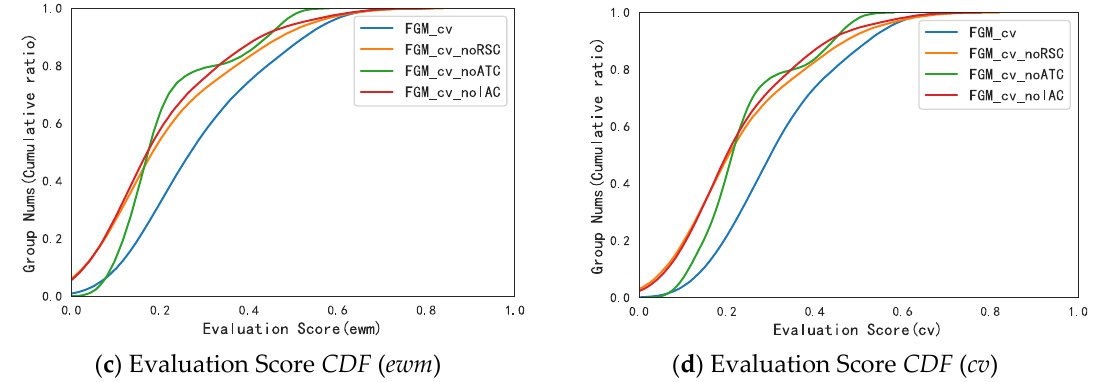
Figure 9. Collusive Relationships Effectiveness Analysis. Table 7. GroupSpam mean